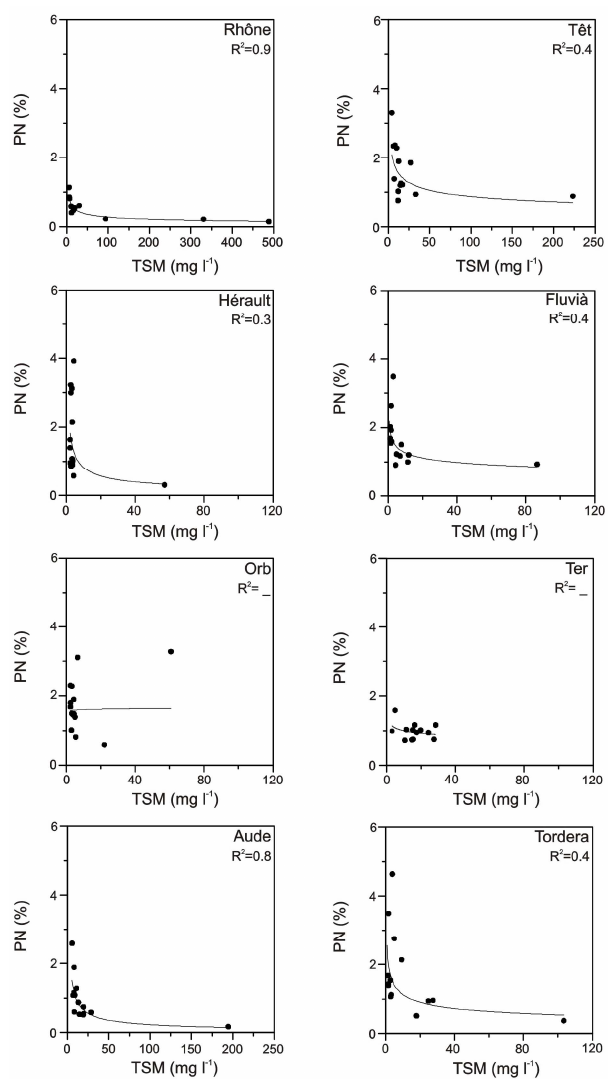
Fig. 7. Relationships between total suspended matter (TSM) and Figure 7. Relationships between total suspended matter (TSM) and particulate nitrogen (PN) 860 particulate nitrogen (PN) contents (in percentage) with R 2 values contents (in percentage) with R 2 values obtained using this equation: PN% = a·TSM b , where a 861 obtained using this equation: PN% = a × TSM b , where a and b are and b are regression coefficients. 862 regression